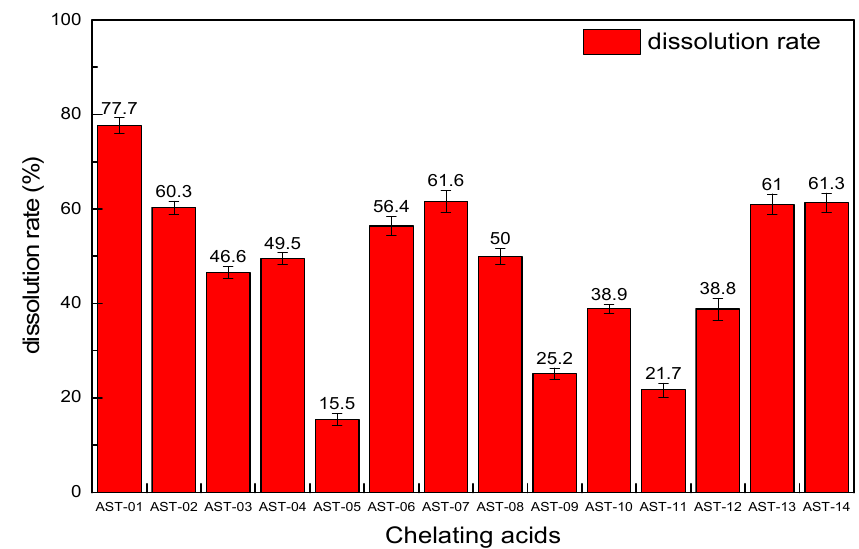
Figure 6. The dissolution rate of 14 kinds of chelating acids.